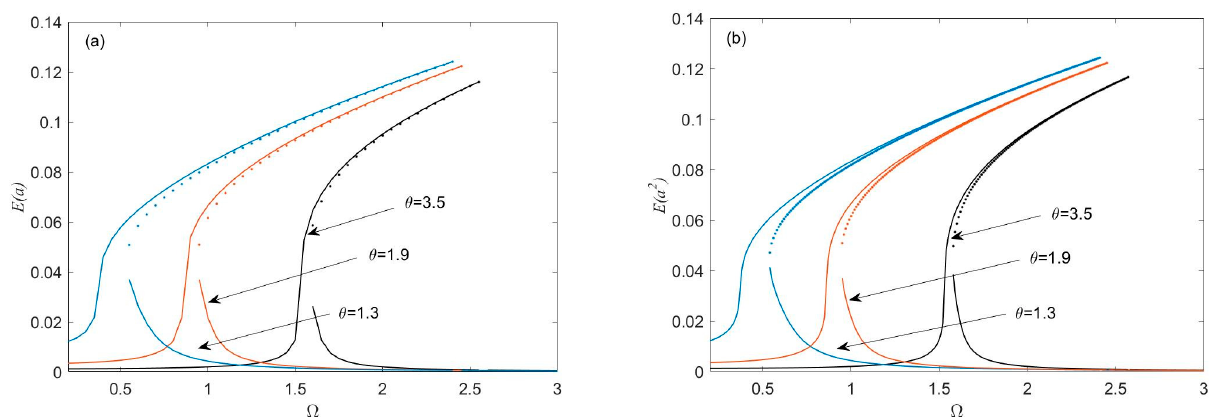
Figure 6. Frequency–amplitude responses of the stochastic SMA oscillator system (11) for different temperatures θ : ζ = 0.1, β = − 1.3 × 10 3 , γ = 4.7 × 10 5 , h = 0.06. ( a ) First-order moment of amplitude a ; ( b ) second-order moment of amplitude a .